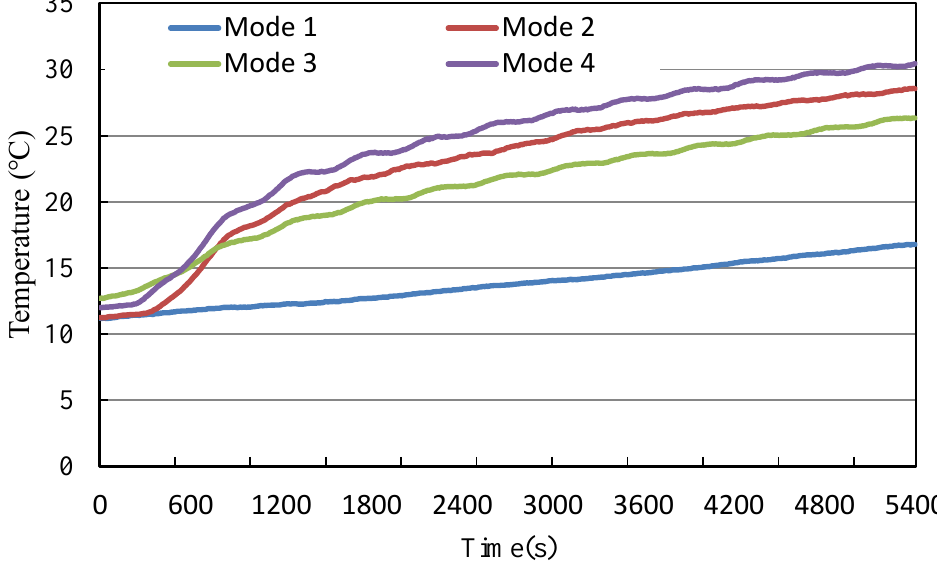
Figure 6. Floor surface temperature.